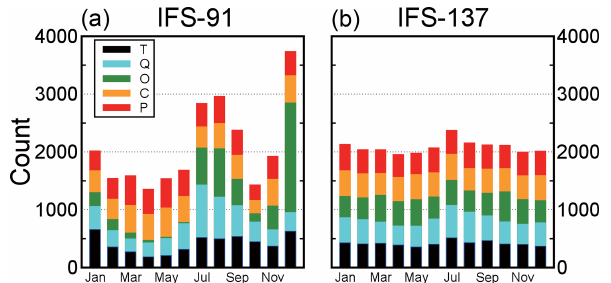
Figure 8. Distribution of profiles within the calendar months in IFS-91 (a) and IFS-137 (b) databases. Different subsets are shown in different colors. Black parts stand for temperature. Blue parts represent specific humidity. Green parts indicate ozone subset. Orange parts stand for cloud condensate. Red parts represent precipitation. Taken from https://www.nwpsaf.eu/site/ update-137-level-nwp-profile-dataset/ (last access: 26 April